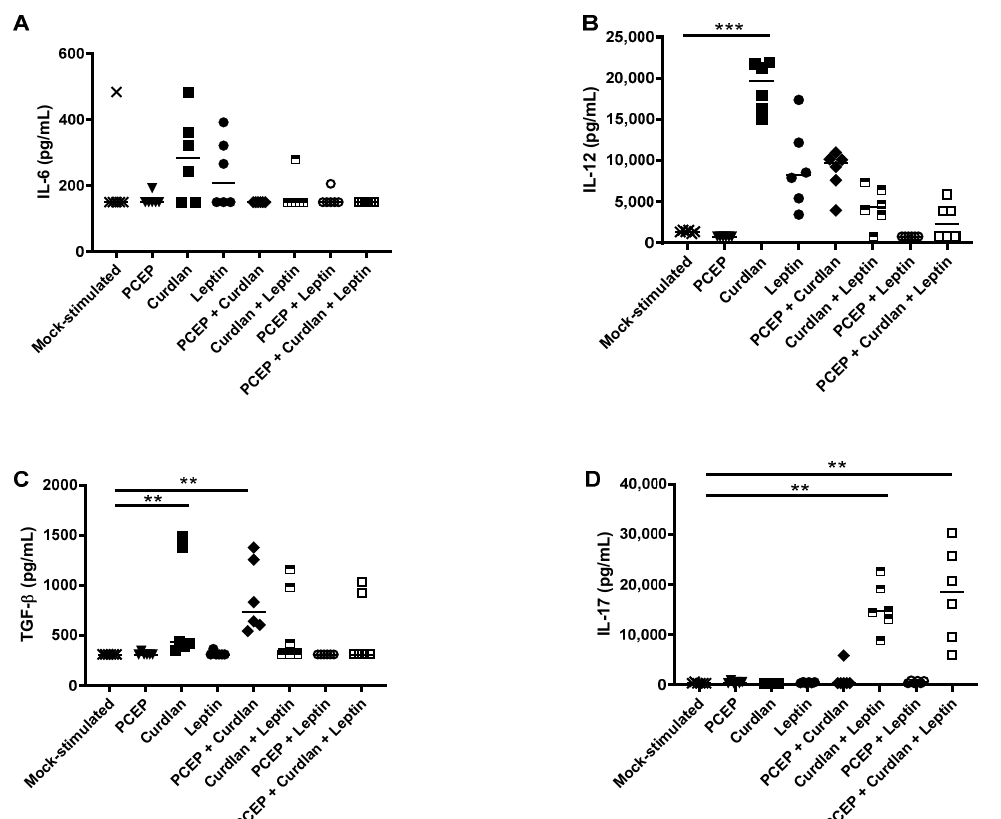
Figure 4. Expression of IL-6, TGF- β , IL-12 and IL-17 in murine splenocytes in response to immunostimulants, in vitro. Splenocytes were harvested from BALB/c mice ( n = 6) and stimulated with PCEP (50 µ g/mL), Curdlan (1 µ g/mL), Leptin (1 µ g/mL), PCEP+Curdlan, PCEP+Leptin, Curdlan+Leptin, and PCEP+Curdlan+Leptin. Supernatants were collected 48 h after treatment and analyzed by ELISA in pg/mL. Values were calculated with respect to the ELISA threshold limit of detection as ( A ) IL-6 (150), ( B ) TGF β (370), ( C ) IL-12 (3120), ( D ) IL-17 (310) pg/mL. Data shown are presented as the mean of duplicate titres for individual biological replicates and the horizontal line represents the median value for the group. Statistical analysis was performed by one-way ANOVA and the differences between the treatments were compared by Kruskal–Wallis and Dunn’s multiple-comparison tests. Significant differences are depicted as follows: ** p < 0.01, *** p < 0.001.